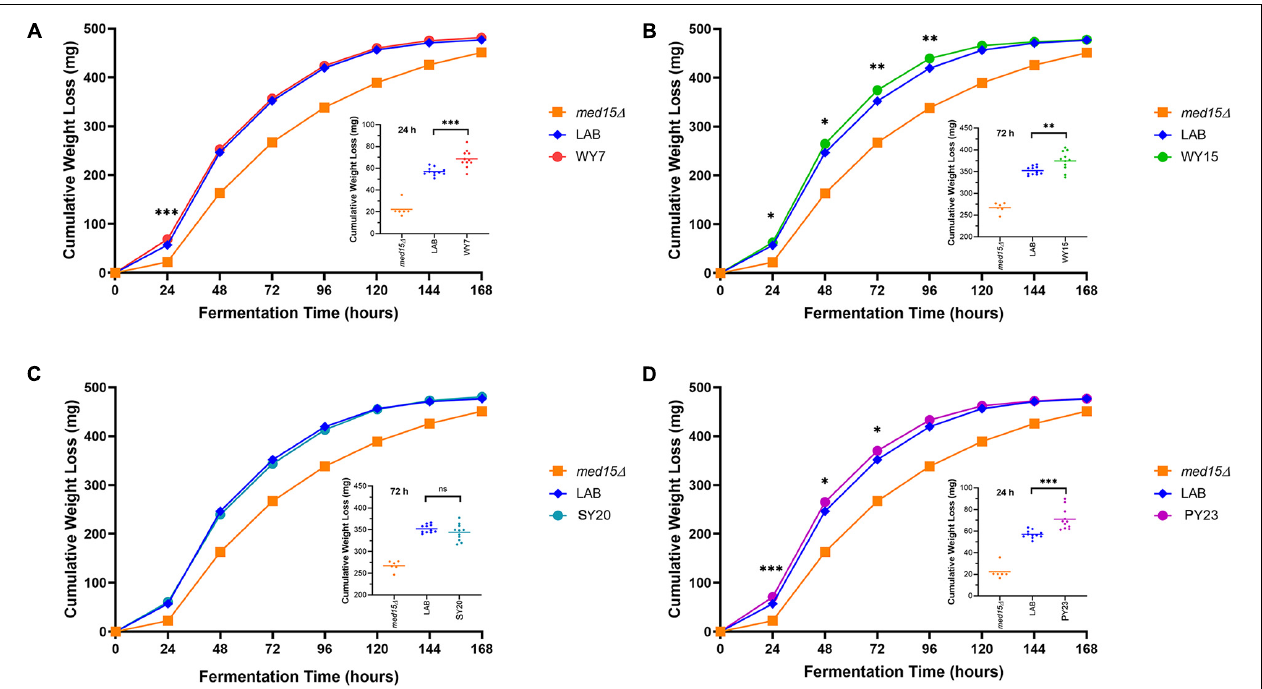
FIGURE 7 | Fermentation of white grape juice is boosted by MED15 alleles from alcoholic beverage yeast. (A–D) Relative cumulative weight loss in WGJ fermentation experiments for the med15 (cid:49) strain (OY320) carrying plasmids expressing the LAB (S288C) or MED15 -WY/SY/PY alleles. Fermentations were conducted at 25 ◦ C with constant agitation as shown in Figure 1C . For all panels, data points are the averages of 10 biological replicates (transformants) and error bars are the standard deviation of the mean. Significance was determined using two-tailed t -tests. ∗ , p ≤ 0.05; ∗∗ , p ≤ 0.01; ∗∗∗ , p ≤ 0.001. Insets depict the distribution of data points for the most significant time